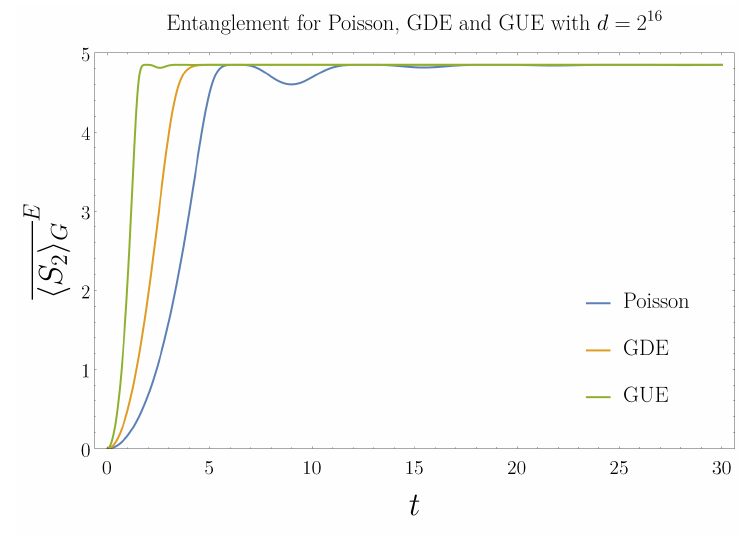
Figure 6: Plot of the r.h.s. of Eq. (45) with ψ GUE ensembles and d = 2 16 . GUE and Poisson reveal oscillations before reaching the equilibrium value in a time O ( d 1 / 12 ) and O ( d 1 / 8 )